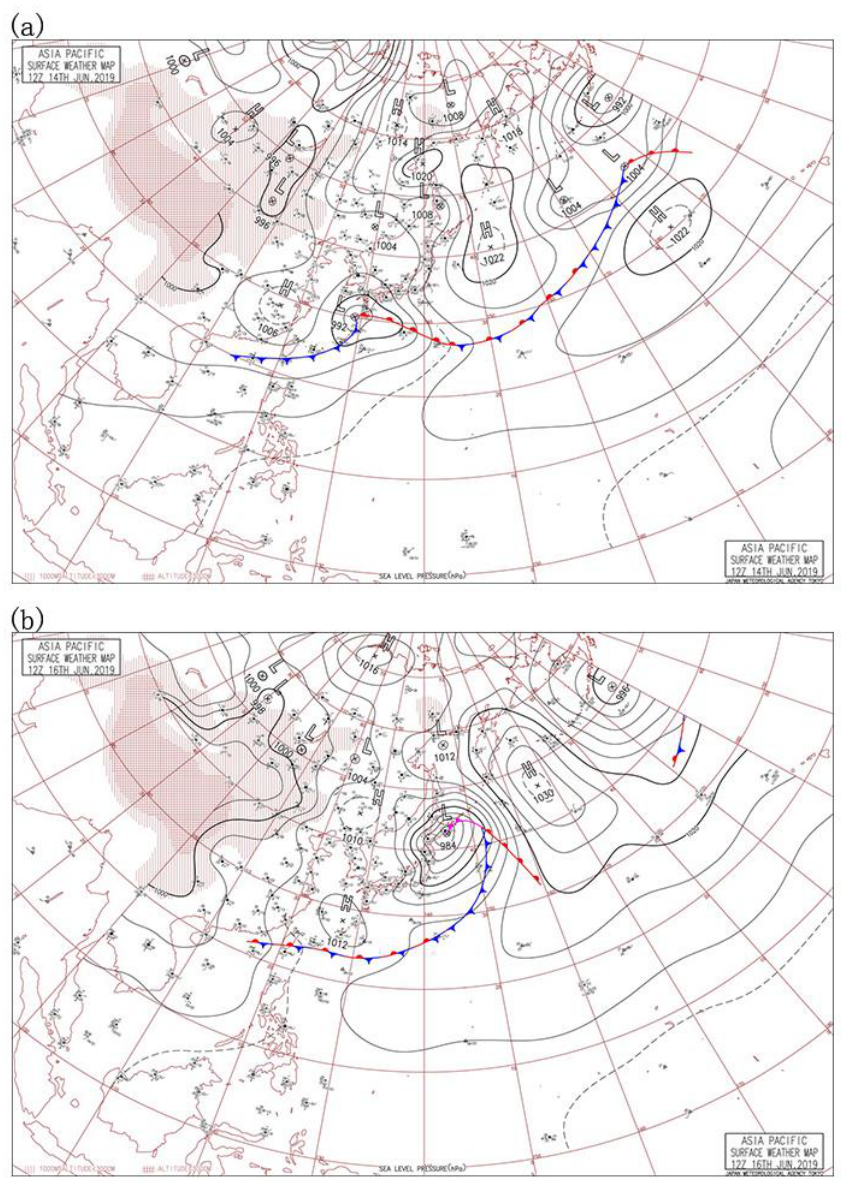
Figure 6. Surface weather maps at 20:00 BJT (UTC+8) on ( a ) 14th and ( b ) 16 June 2019. In these pictures, L represents the center of low pressure, while H represents high pressure. Blue lines with triangles refer to cold fronts, and the side of the triangle is in front of the front. In addition, the blue line on each side of the red-filled circle and the blue triangle represent the quasi-stationary front. Automatic weather stations, located on both sides of the ship, also captured these two processes. The variations in the measured meteorological elements are revealed in Figure 7. Before 14 June 2019, the wind speed rises promptly at an average rate of 1.64 m s −1 day −1 . Temperature firstly increases and then decreases. In addition, a sudden drop in relative humidity and a sudden change in wind direction occur on 14 June 2019. These features are in conformity with the above surface weather map, indicating the passage of the cold front on 14 June 2019.